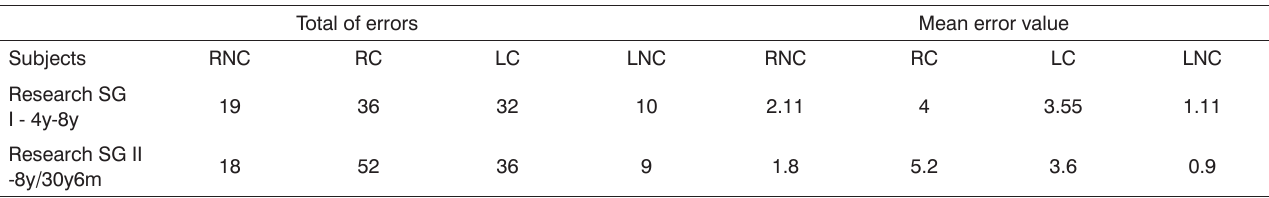
Chart 7. Comparison between total number of errors and percent mean values for research subgroup I (used drugs for less time) and research subgroup II (used drugs for